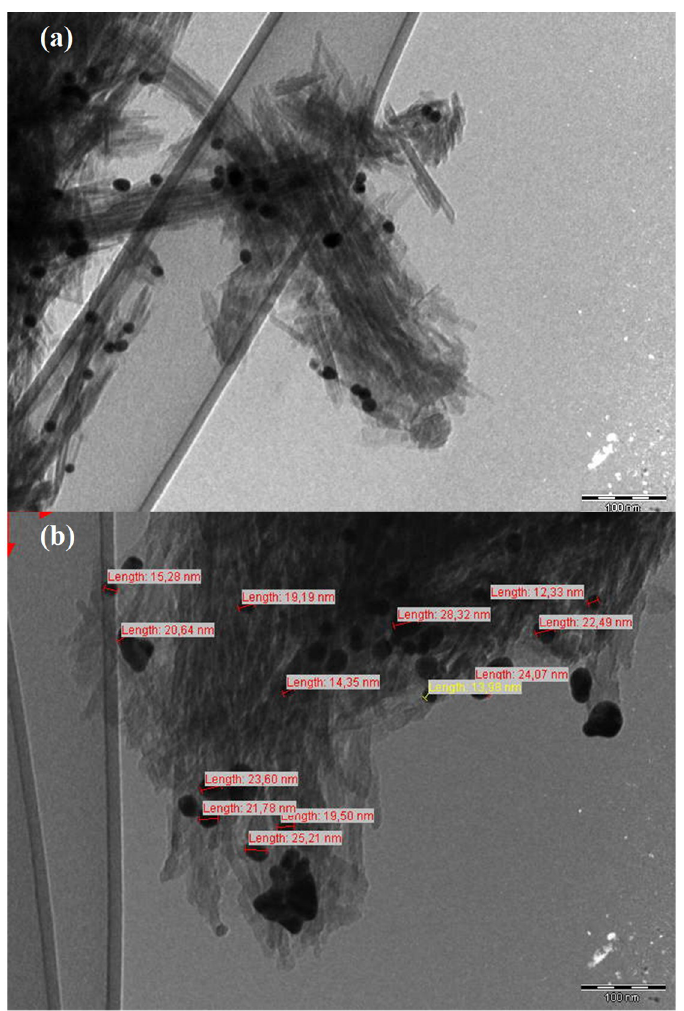
Figure 9. TEM images of 25 ppm AuNPs loaded onto modified sepiolite samples: 200 nm scaled ( a ) and 100 nm scaled ( b ), respectively.